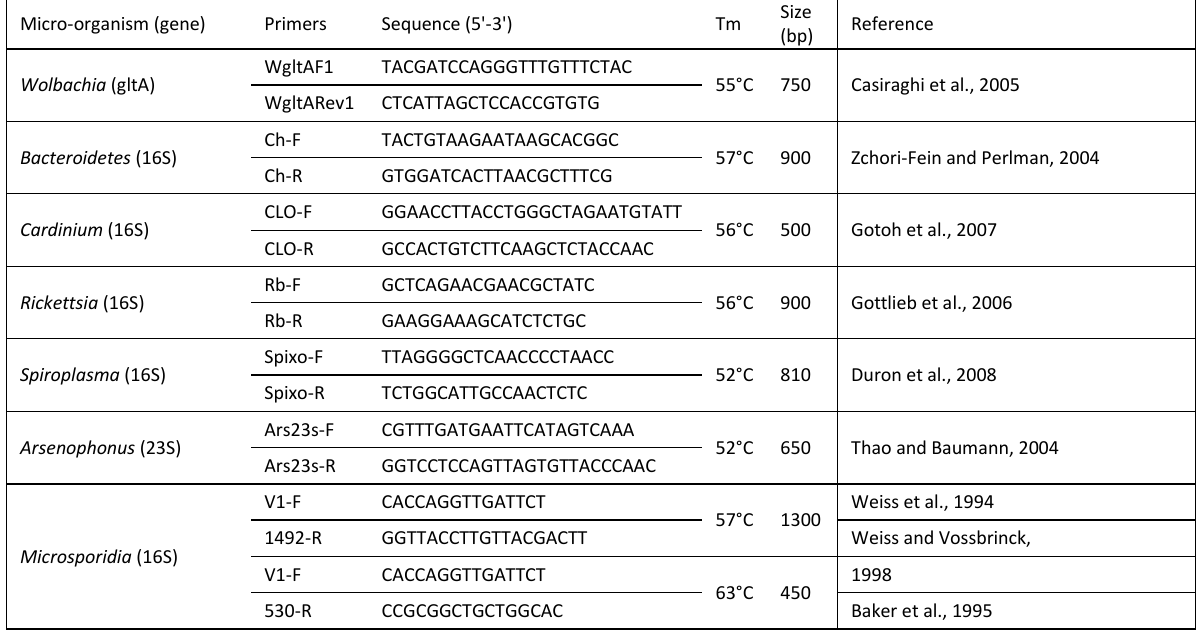
Supplementary Table 3: List of the micro-organisms whose presence was tested in C. typhae Makindu females, by PCR with specific